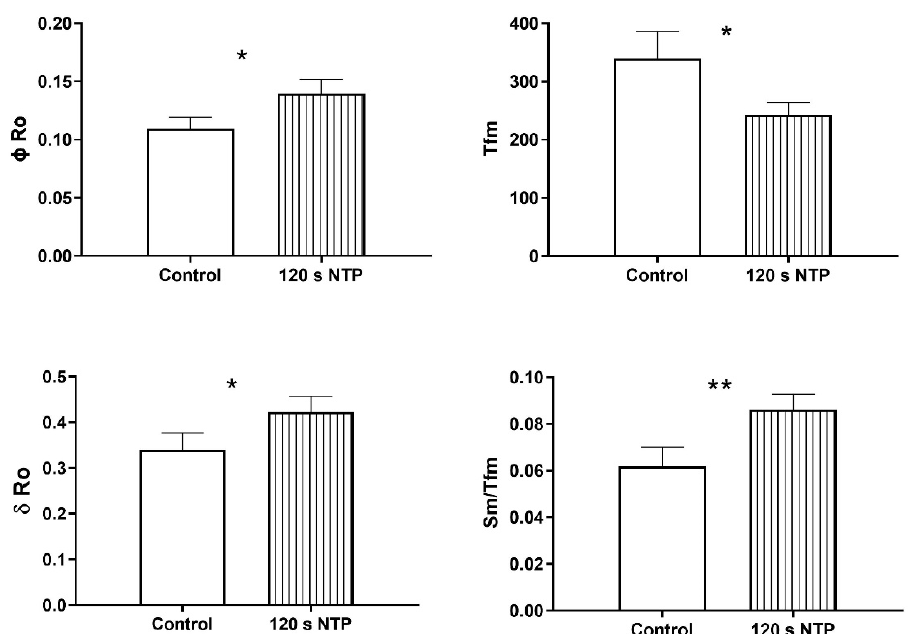
Figure 7. Effects of NTP treatment (120 s every hour) of nutrient solution on chlorophyll a fluorescence of leaves of lettuce plants grown hydroponically with nutrient solution treated with NTP (120 s). (left) Parameters related to PSI activity, the φ Ro (quantum yield for reduction in end acceptors of PSI per photon absorbed) and δ Ro (efficiency with which an electron can move from the reduced intersystem electron acceptors to the PSI end electron acceptors). (right) Tfm: time to reach maximal fluorescence and Sm/tFM: average fraction of open reaction centers during time needed to complete their closure. Each value is mean of two replicates ( ± SE, n = 7). Pairwise comparisons between means performed using a two-tailed unpaired Student’s t tests assuming equal variances (* p < 0.05; ** p < 0.01).